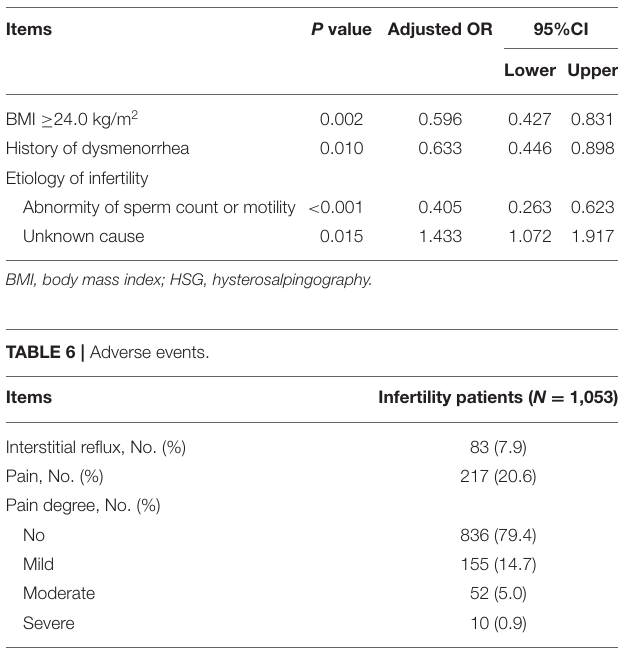
TABLE 4 | Live birth rate among patients with different clinical characteristics. TABLE 5 | Multivariate logistic regression analysis for live birth.